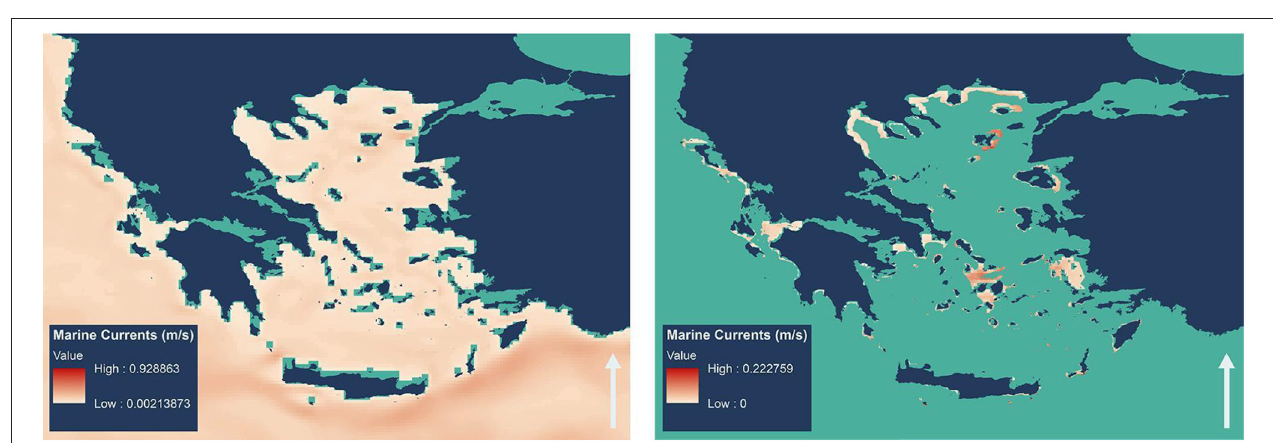
FIGURE 6 | Wave Energy potential in Greece. (Left) Potential in the whole Greek territory. (Right) Areas of exploitable potential focused on sites with proper bathymetry, out of nature protected areas and within greek territory sea (Maestrale WEBGIS, 2018). Further editing by overlapping the layers referred in open source vector software.